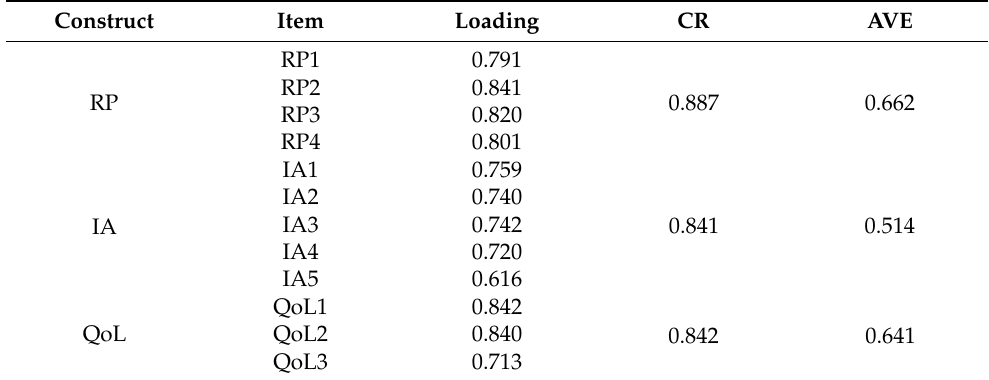
Table 2. Factor loading of items. Construct